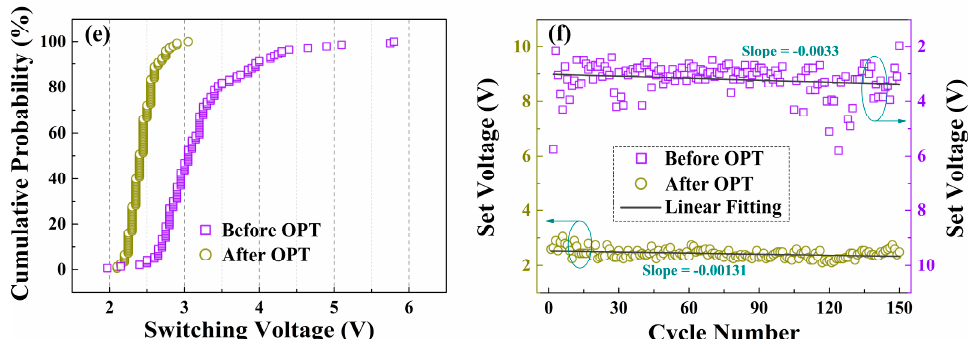
Figure 4. Typical I - V curves of the as-deposited HfO x nanofilm measured by in situ C-AFM at I cc of 20 nA after 10, 40 times voltage sweepings respectively, ( a ) before OPT showing an excursion in I-V curves and ( b ) after OPT showing no excursion in I-V curves. SET processes curves of ( c ) the as-deposited HfO x nanofilm and ( d ) the HfO x nanofilm after OPT. ( e ) Cumulative probability of V SET in HfO x nanofilm before and after OPT. ( f ) Linear fitting of V SET in HfO x nanofilm before and after OPT from 150 switching times.